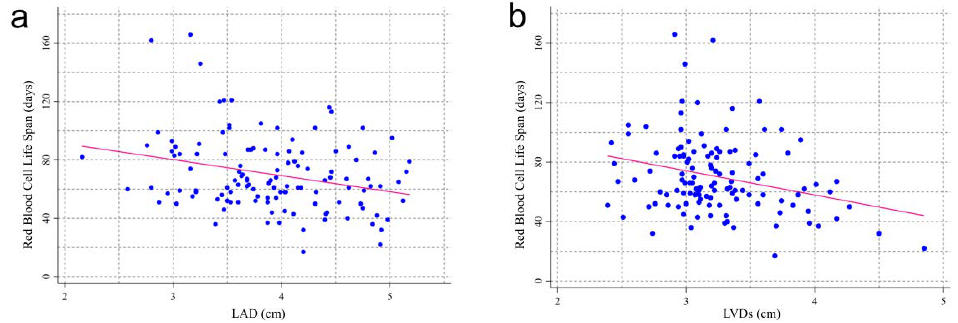
LAD, left atrial internal diameter; LVDd, left ventricular end-diastolic internal diameter; LVDs, left ventricular end-systolic internal diameter; IVST, interventricular septum thickness; LVPW, thick- ness of left ventricular posterior wall; LVEF, left ventricular ejection fraction; E/e, early diastolic blood flow velocity at the mitral cusp/early diastolic myocardial motion velocity at the mitral annu- lus; LVM, left ventricular myocardial mass; CO, cardiac output. a p < 0.05 vs. RBCLS ≥ 70 d group; b p < 0.05 vs. 60 ≤ RBCLS < 70 d group; c p < 0.05 vs. 50 ≤ RBCLS < 60 d group.